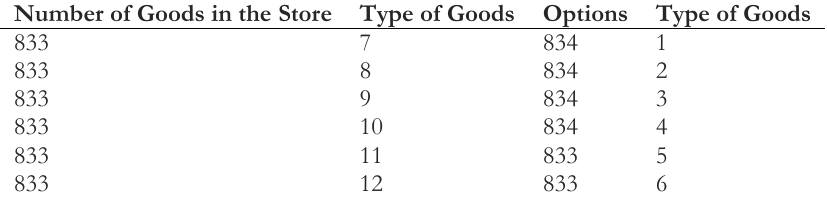
Table 5. Number of goods in store (source: model-assumptions).